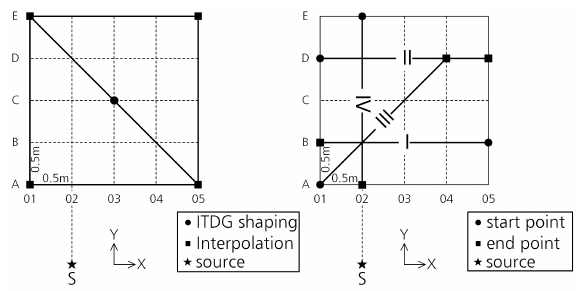
Figure 13. Auralized setup used for quality evaluation; Left : marked are the measurement points of BRIRs used for ITDG shaping and for the interpolation approach. Right : walkable paths (I to IV) used in the evaluation (data from the work in